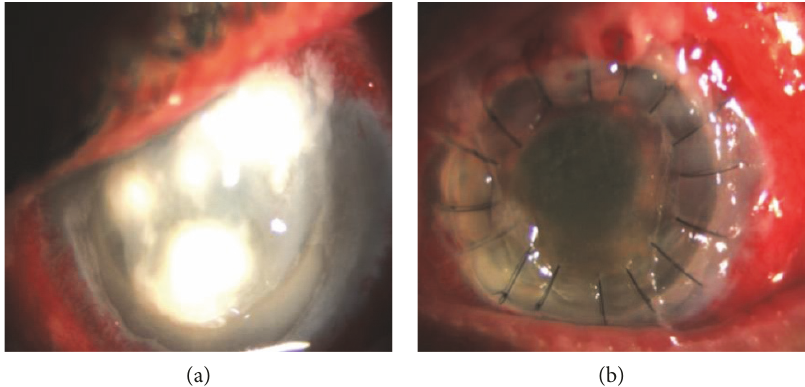
Figure 4: (a) Fungal keratitis post DSAEK. (b) Same patient after therapeutic penetrating keratoplasty.